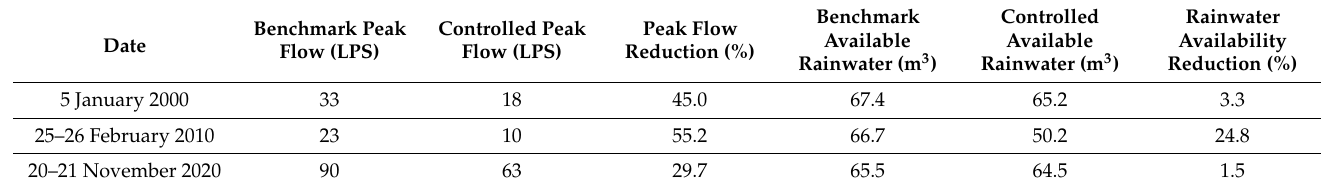
Table A2. Results of applying the optimization method on measured rain events from the Beit Dagan rain